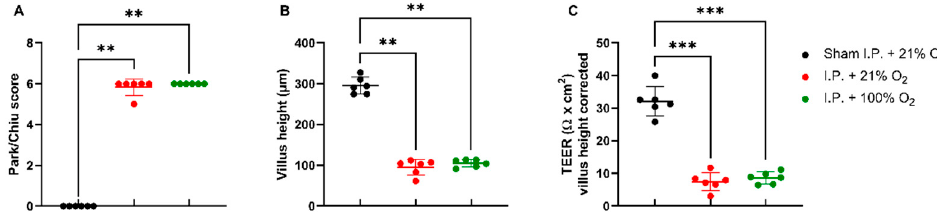
Figure 2. The impact of oxygen supplementation on intestinal epithelial injury was scored according to the Park–Chiu score ( A ) and villus height ( B ). Intestinal epithelial permeability was measured by TEER in an Ussing chamber setup, which was corrected for the villus height ( C ). ( n = 6/group). I.P.: intraperitoneal injection anesthesia; O 2 : oxygen; TEER: transepithelial electrical resistance. ** p < 0.01; *** p < 0.001.